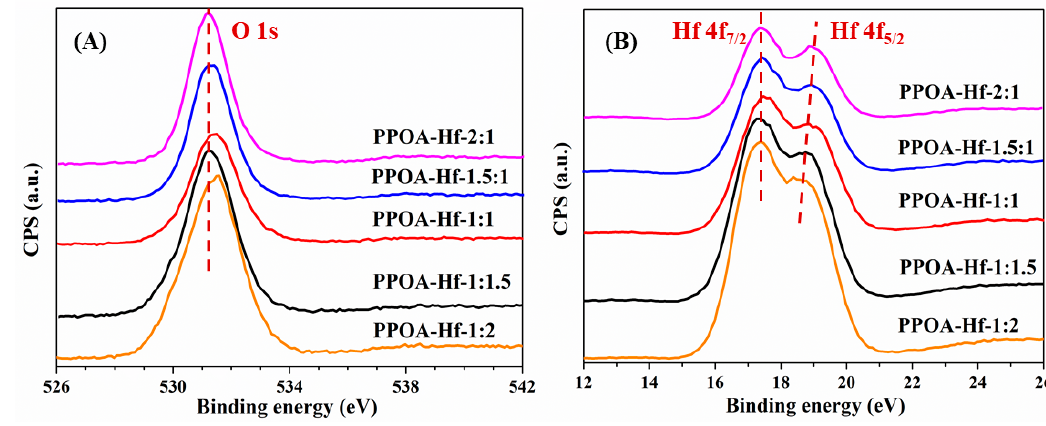
Figure 4. X-ray photoelectron spectroscopy (XPS) spectra of ( A ) O 1s, and ( B ) Hf 4f in PPOA–Hf- x with various PPOA/Hf molar ratios.